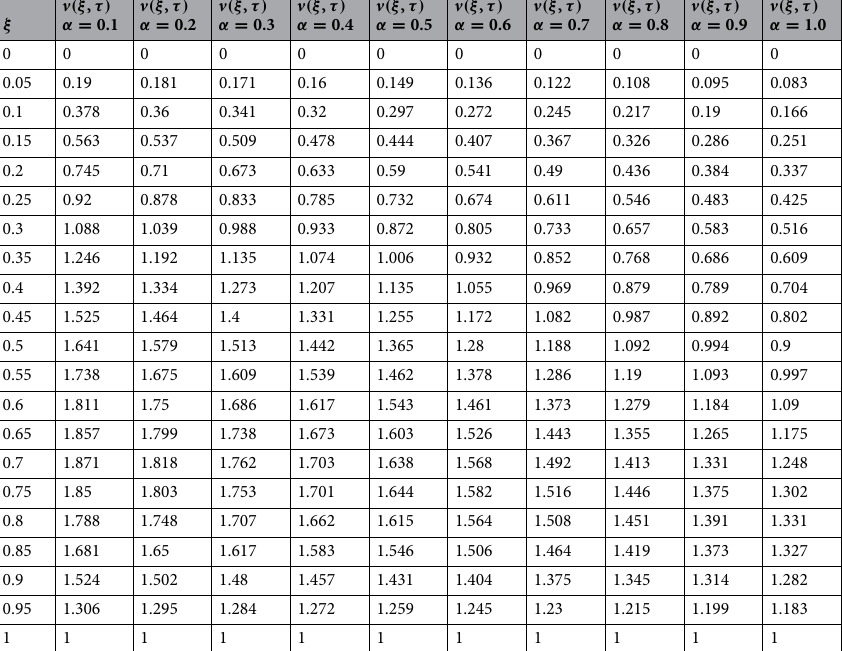
Table 1. The influence of fractional parameter on the flow